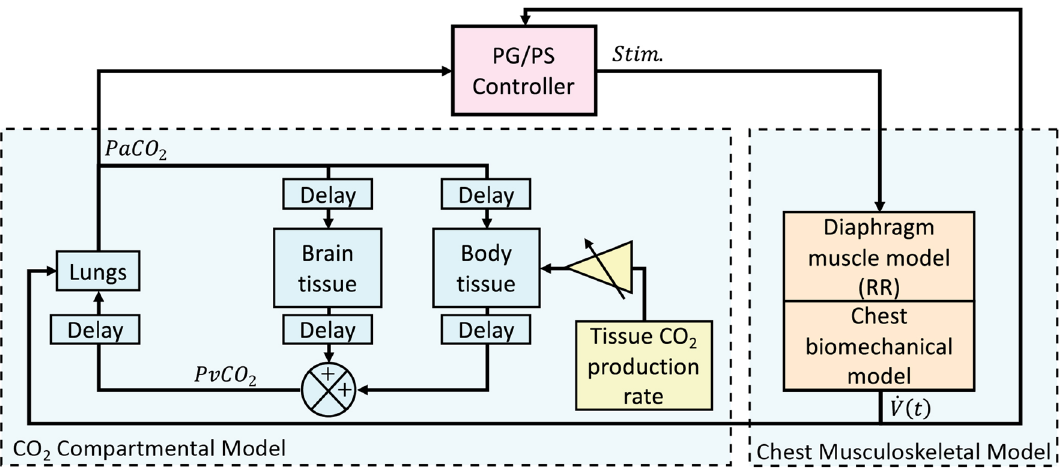
Figure 3. Block diagram of the computational testbed used to assess the PG/PS controller in silico. A chest musculoskeletal model with reverse recruitment (RR) dynamics and a CO 2 compartmental model were